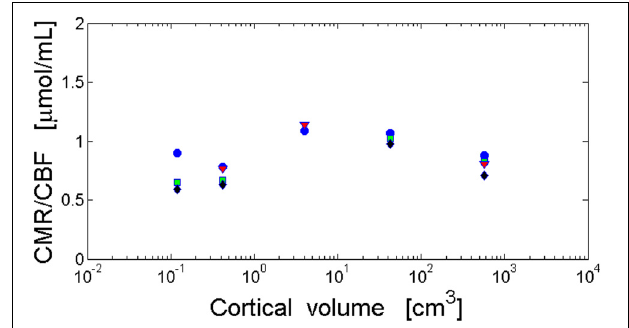
FIGURE 4 | Invariance of the ratio of cortical metabolism to cortical blood flow (CMR/CBF) with respect to brain size. The ratio CMR/CBF is independent of cortical volume and cortical area. The log–log fit gives non-significant scaling exponents close to zero. Visual cortex (blue circles): y = 0 . 012 x − 0 . 037 and r = 0 . 288 , p = 0 . 638. Frontal cortex (green squares): y = 0 . 041 x − 0 . 14 and r = 0 . 774 , p = 0 . 226. Temporal cortex (black diamonds): y = 0 . 036 x − 0 . 17 and r = 0 . 626 , p = 0 . 374. Parietal cortex (red triangles): y = − 0 . 006 x − 0 . 044 and r = − 0 . 094 , p = 0 . 940. Data from Table 2